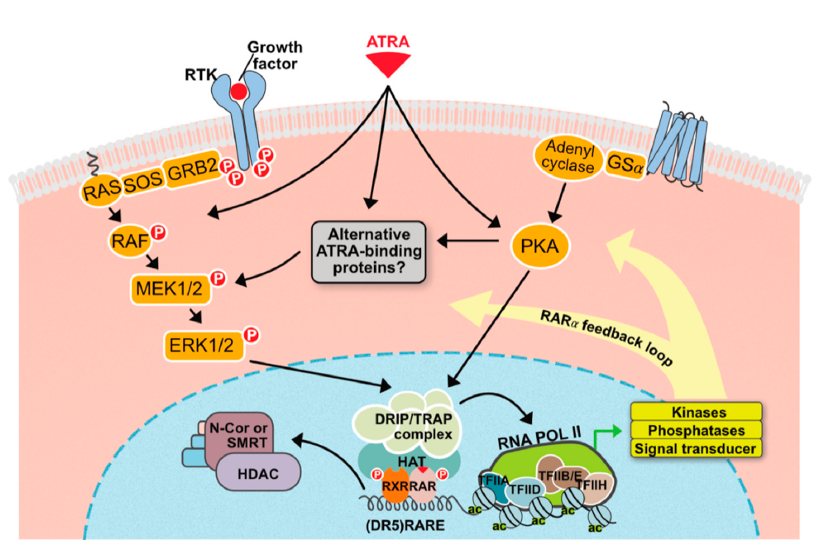
Figure 2. Non-genomic effects of ATRA. ATRA can cause rapid activation of various cellular kinases: shown above is the convergence of genomic and nongenomic signaling. Additionally, by directly up-regulating the expression of components of various signaling cascades, ATRA provides a positive feedback loop mechanism. Possibilities also exist for antagonistic interactions, which are not highlighted in the figure.